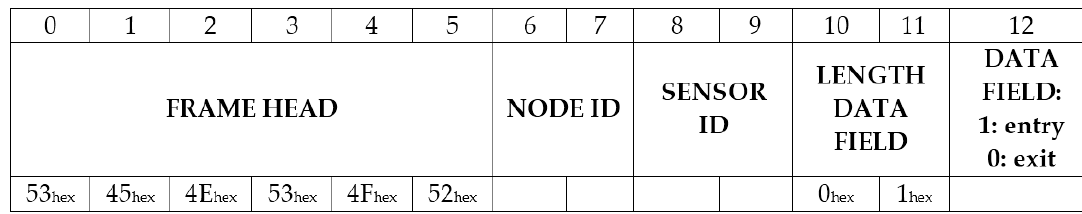
Figure 10. Structure of data packet sent by the sensor nodes to notify vehicle entry or exit.